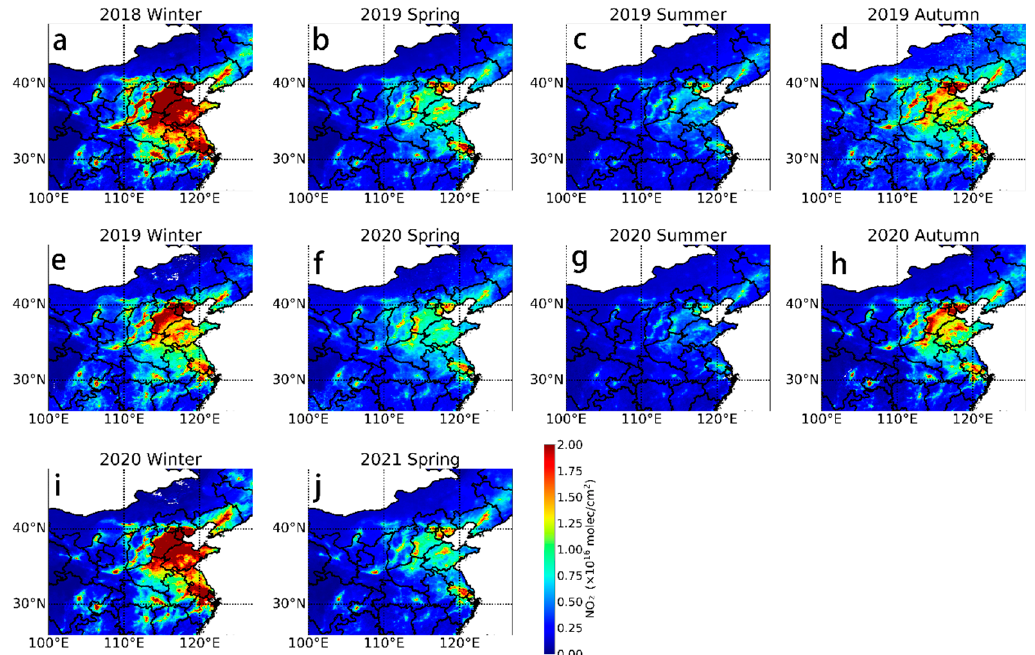
Figure 4. Seasonal mean distribution of the spatiotemporal NO 2 distribution in eastern China. ( a )